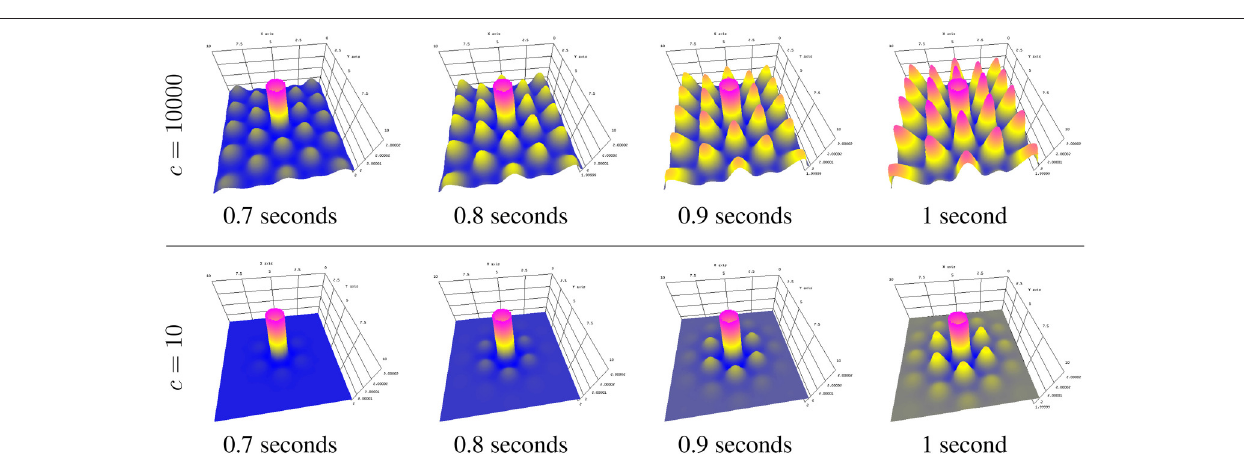
FIGURE 7 | Activity spread with large speed c (top) and small speed c